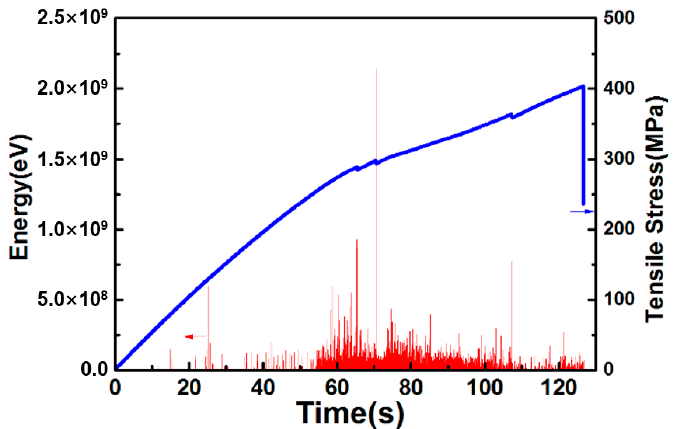
Figure 7. The typical AE energy distribution in contrast with the load curve.